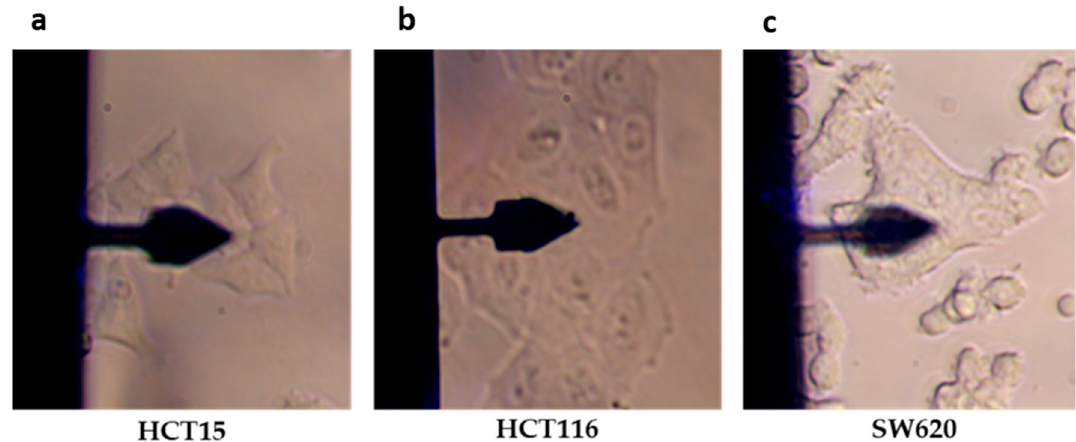
Figure 4. Representative images of cell types used for quantification of their biomechanical properties by AFM, using a model PFQNM-LC-A-CAL cantilever. ( a ) HCT15, ( b ) HCT16, and ( c ) SW620 cells. with a boxplot displaying the median and the respective percentiles (25th and 75th).